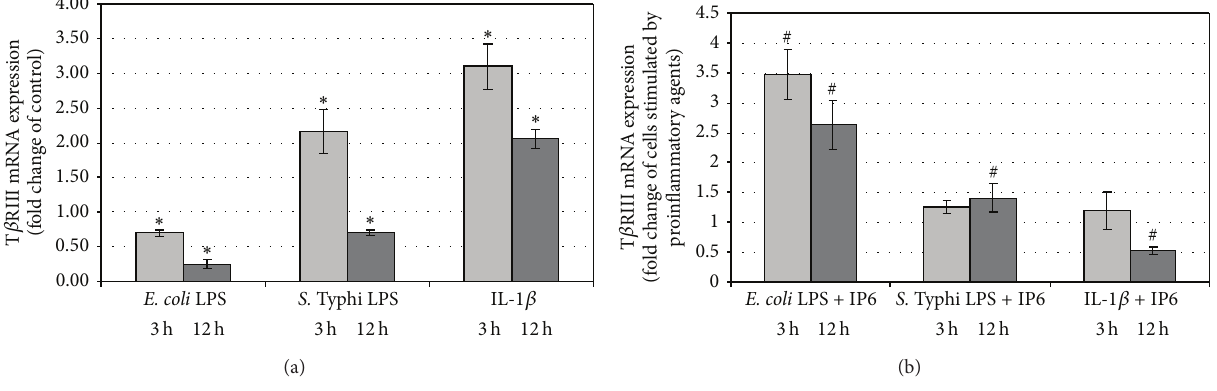
Figure6:ExpressionofT 𝛽 RIIIgeneinCaco-2cellsasdeterminedbyreal-timeRT-PCR.ChangesinT 𝛽 RIIImRNAexpressioninCaco-2cells after treatment with (a) proinflammatory agents and (b) proinflammatory agents and 2.5 mM IP6 for 3h and 12h. The results are presented as mean ± SD of three separate experiments; ∗ 𝑃 < 0.05 versus control Caco-2 cells; # 𝑃 < 0.05 versus proinflammatory agents-stimulated